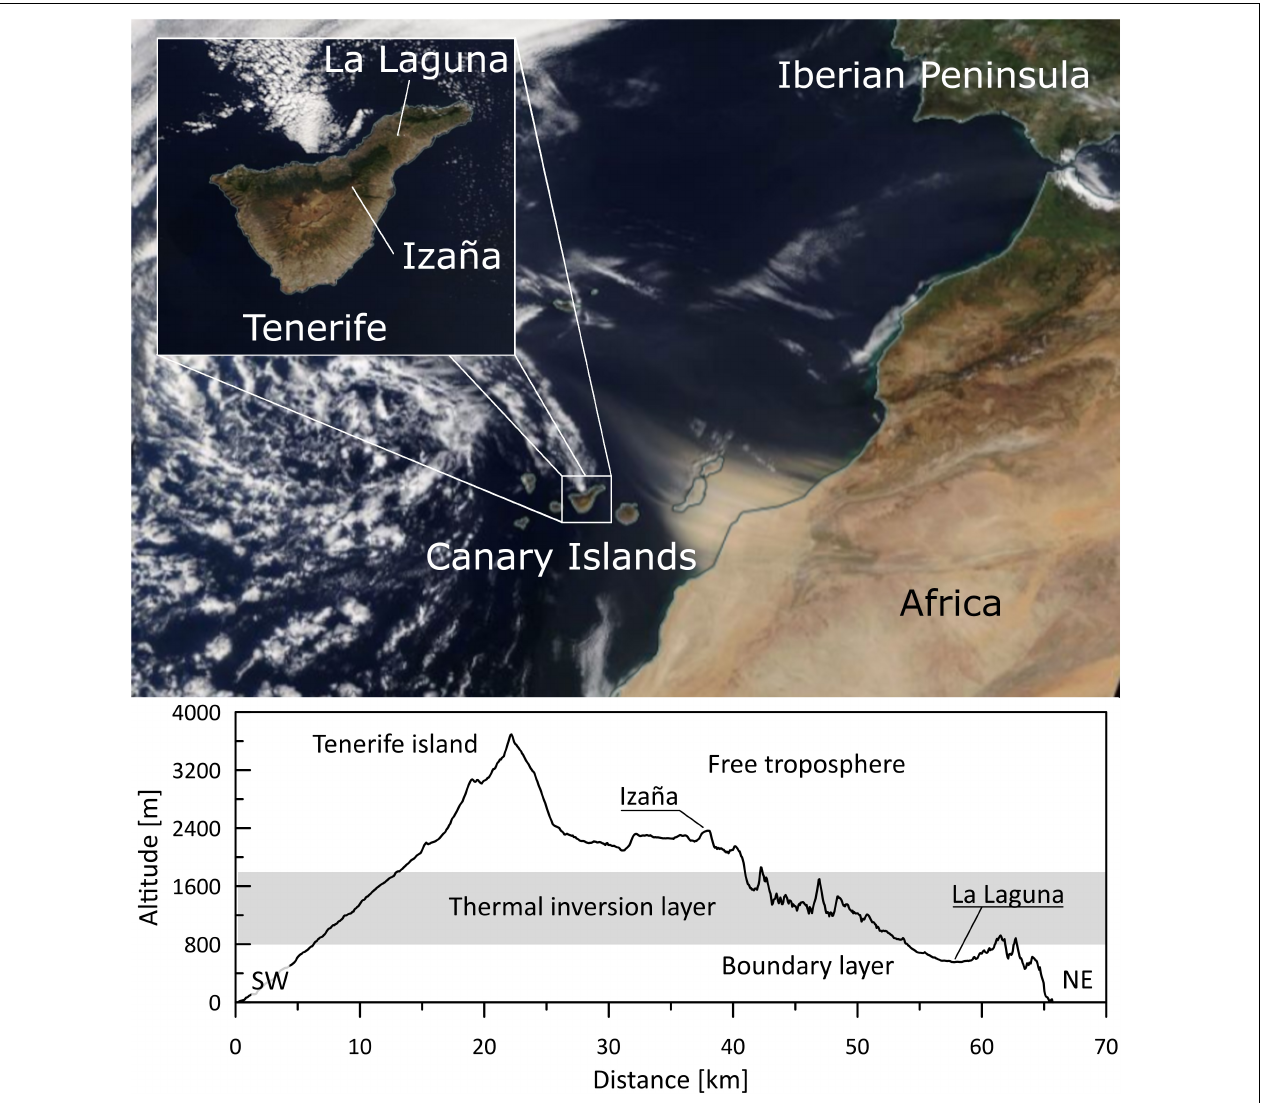
FIGURE 1 | Location of the Izaña and La Laguna stations in Tenerife, Spain (top), and vertical cross section of the island showing the atmospheric vertical layers